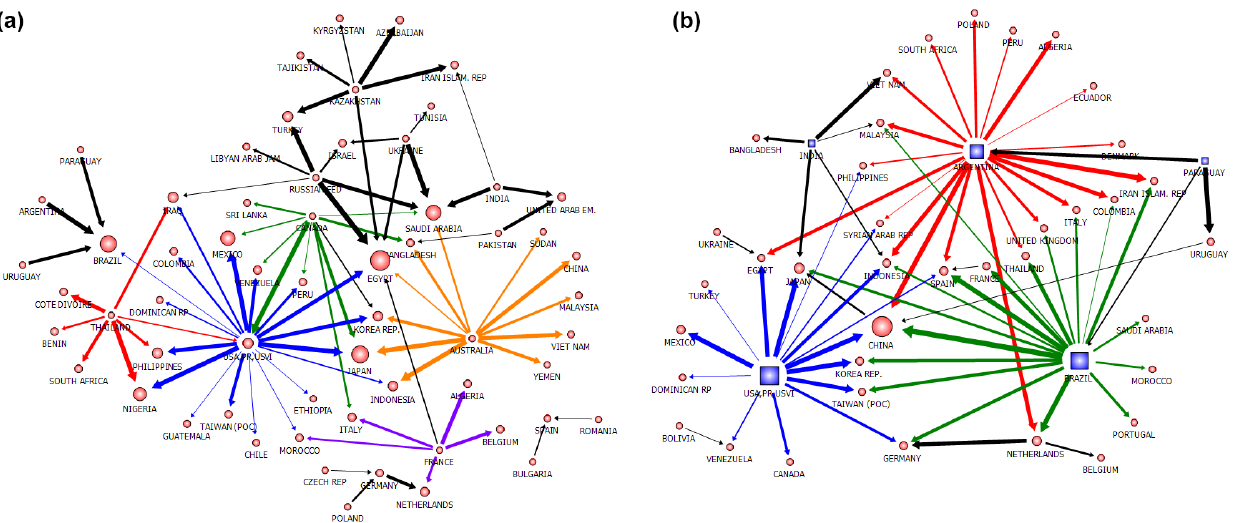
Figure 2. The GVWT network through food and feed crop trade in 2010. (a) Food crops (wheat, barley, rice, rye, and sorghum) and (b) feed crops (maize and